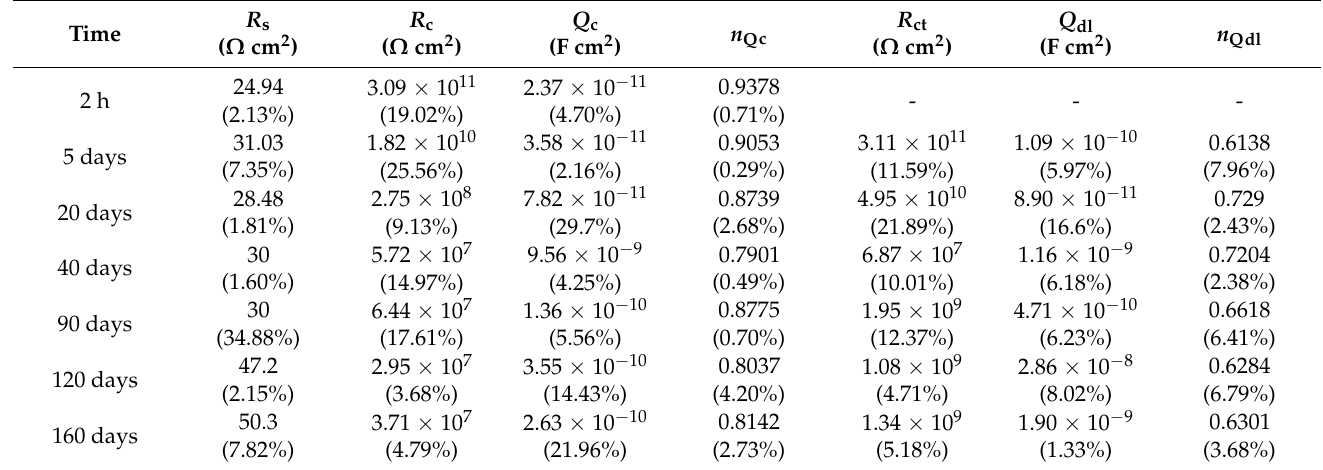
Table 3. The impedance fitting parameters of the FW-2 coating